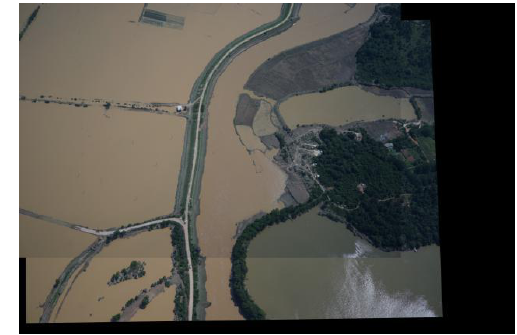
Figure 7. Registration of two images